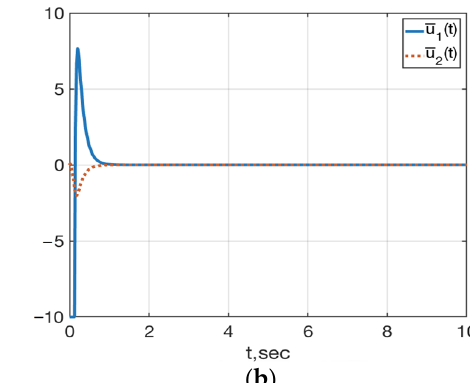
. x = ( 1.1 A + 0.9 BF ) x , (59), (69), (70)